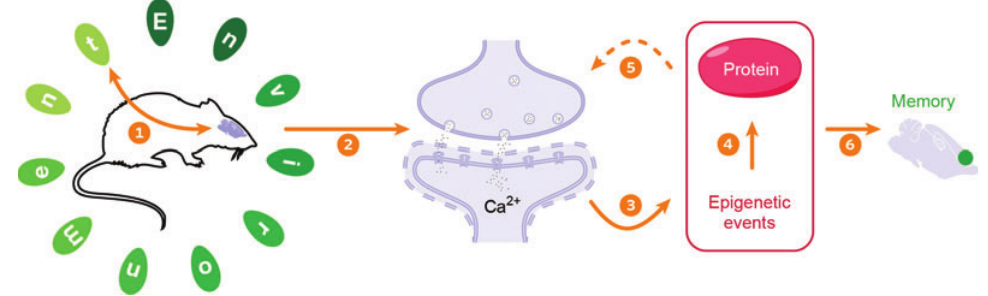
Figure 1 Outline of the basic structural and molecular events that take place during memory formation. Associative learning can be induced by different environmental factors (1) , which will lead to cellular changes in the brain in order to induce structural plasticity and increase synaptic strength (2) . The transcriptional program is regulated in part by epigenetic events in order to dynami- cally modulate protein synthesis through transcriptional activation and silencing (3, 4) to establish long lasting memory (6) . Thus, epigenetic changes can mediate and be mediated by behavioral changes, synaptic plasticity and structural changes (i.e., spine enlargement) to potentiate long-term memory processes (3, 5)